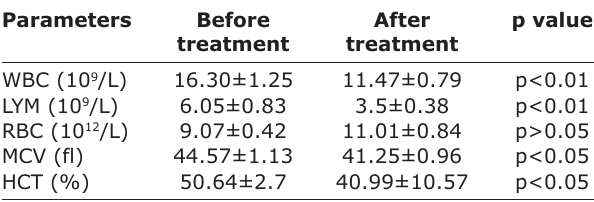
Table-2: Hematological changes and after treatment